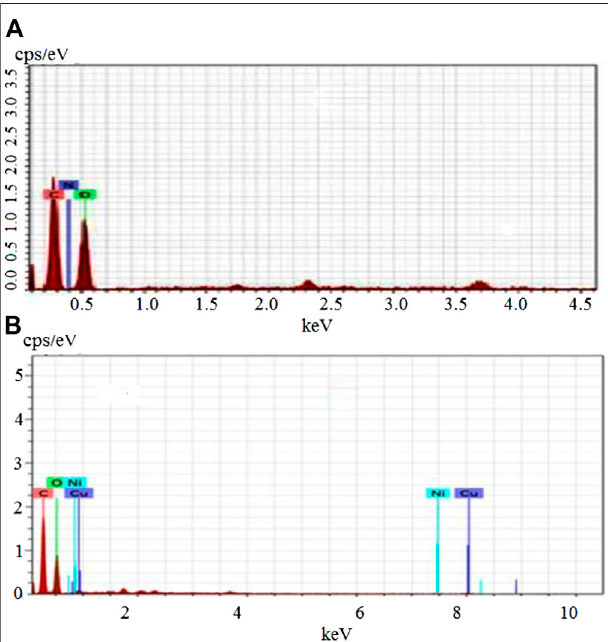
FIGURE5|(A,B) EDSof (A) Kg-cl-poly(AA)and (B) Kg-cl-poly(AA)-Cu-